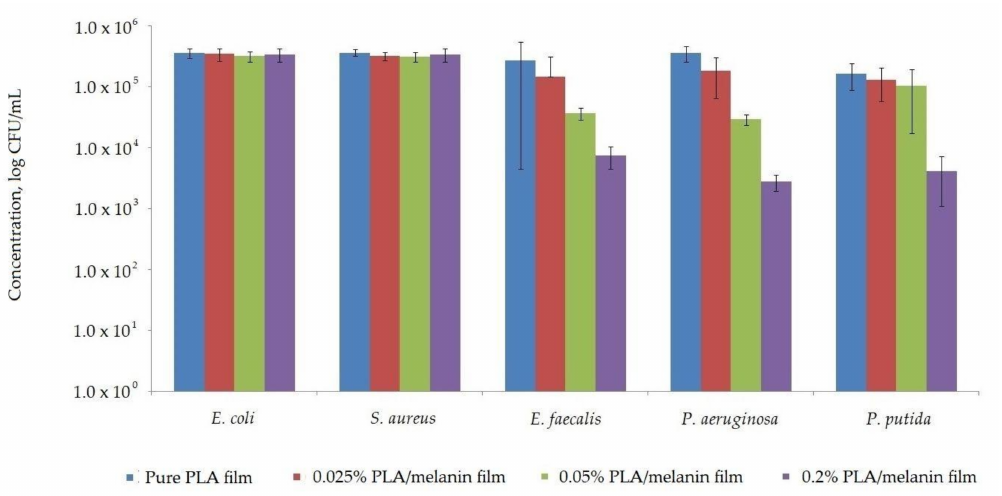
Figure 8. The influence of pure PLA and PLA/melanin modified films on E. coli , S. aureus , E. faecalis , P. aeruginosa and P. putida